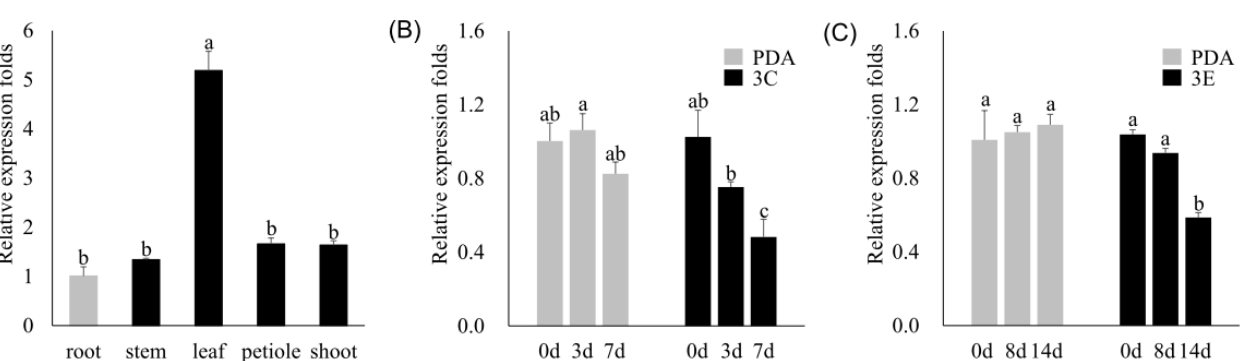
Figure 2. Expression characteristics of the PdePrx12 gene. ( A ) Expression of the PdePrx12 gene in the roots, stems, leaves, petioles, and terminal buds of wild-type poplar NL895. The relative expression of PdePrx12 in the roots was set to onefold ( p = 0.05). ( B ) Expression of PdePrx12 on Day 0, Day 3, and Day 7 when 3C infects WT. The relative expression level of PdePrx12 in Day 0 WT leaves was set to onefold ( p = 0.05). ( C ) Expression of PdePrx12 on Day 0, Day 8, and Day 14 when 3E infects WT. The relative expression level of PdePrx12 in Day 0 WT leaves was set to onefold ( p = 0.05). Different letters (a, b ,c and ab) above bars indicated significant difference at p = 0.05.